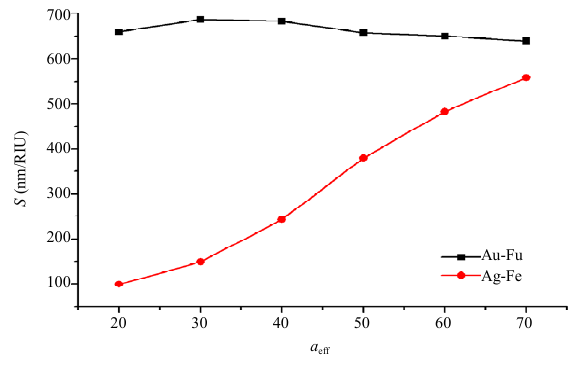
Fig. 9 Relationship between the refractive index sensitivity ( S ) and the particle size ( a eff ).